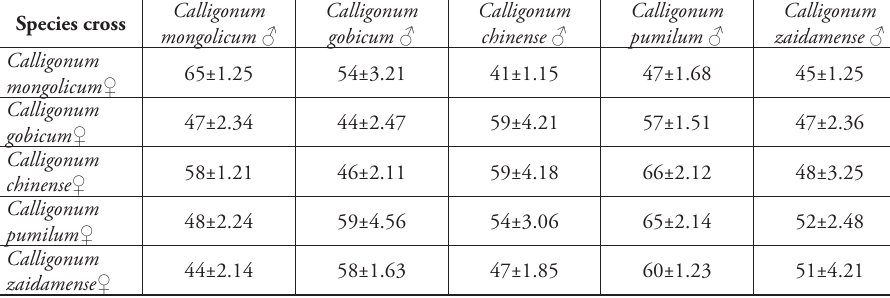
Table 4. Fruit set (%) for the five Calligonum species under different cross-pollination treatments (n = the total number of flowers manipulated in each treatment, mean ± SE).